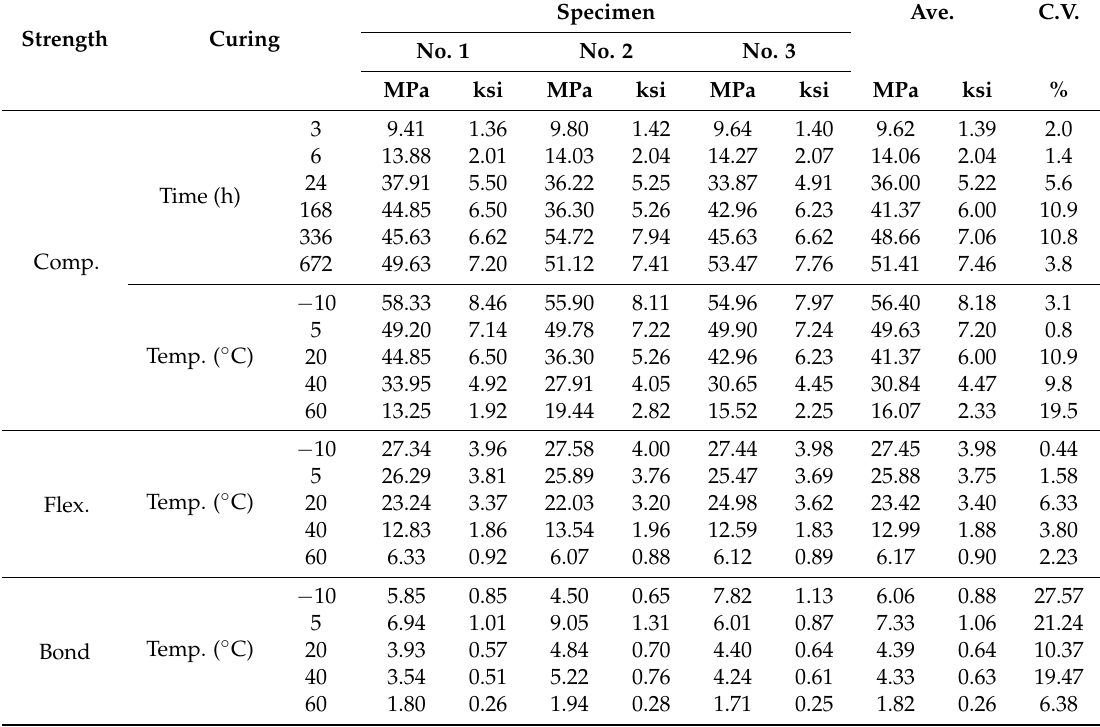
Table 7. Results of strength tests.